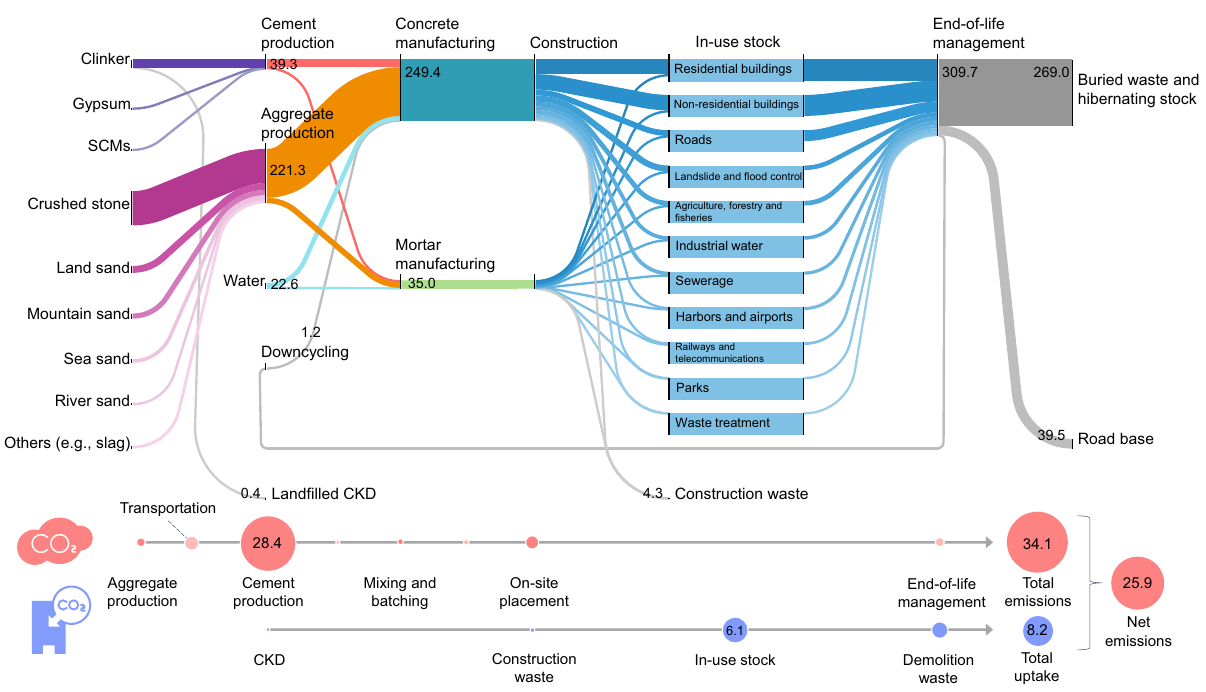
Fig. 1 Cement and concrete cycle and associated-CO 2 fl uxes in Japan in 2019. All fl ows are shown to scale in Mt/year; in-use stocks shown in the box are scaled differently than fl ows. The numbers in the circles at the bottom of the fi gure show the annual CO 2 emissions and uptake associated with the concrete cycle in Mt-CO 2 /year. The Sankey diagram was designed with fl oWeaver 63 . SCMs supplementary cementitious materials, CKD cement kiln